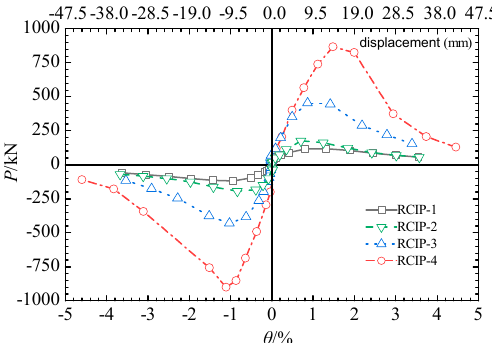
Figure 13. Lateral load–drift ratio envelope curves for the tested specimens.